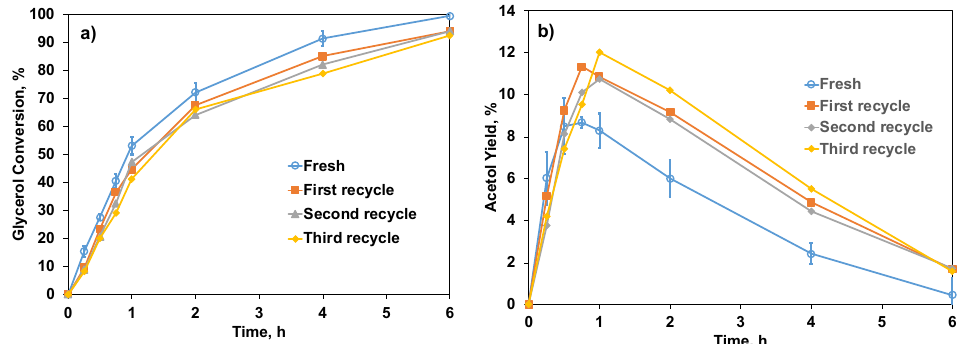
Figure 10. Activities of the recycled catalysts: ( a ) glycerol conversion; ( b ) acetol yield. Reaction conditions: 220 ◦ C, 1.5 MPa N 2 , 20 wt% glycerol, water/methanol molar ratio = 1.2, 3 wt% catalyst with respect to total feed mixture, 6 h reaction time, 500 RPM. Catalyst: 2Pd-CZA, Cu/Zn/Al (molar) = 35/35/30. Error bars: 95% CI.